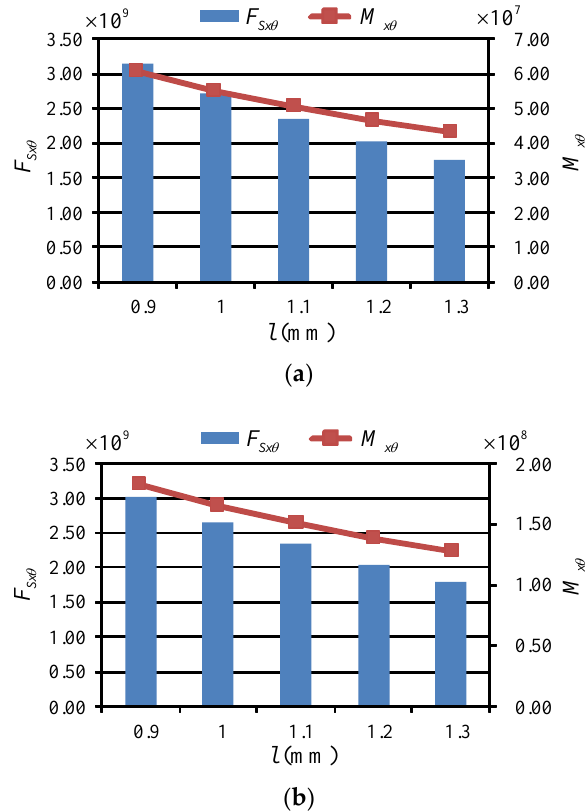
Figure 10. Effect of body length l on modes amplitudes with ( a ) B(2,1); ( b ) B(4,2).